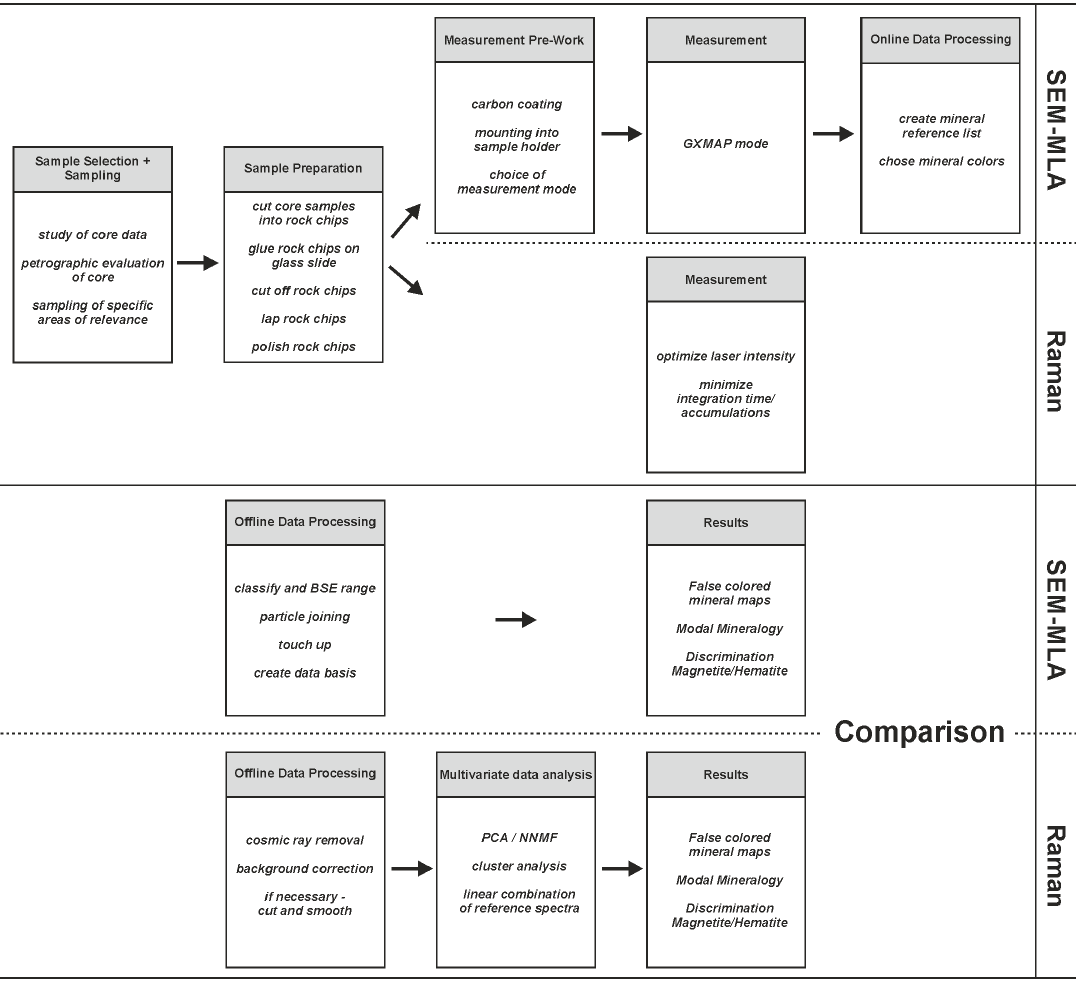
Figure 1. Workflow of the SEM-MLA and Raman analysis.